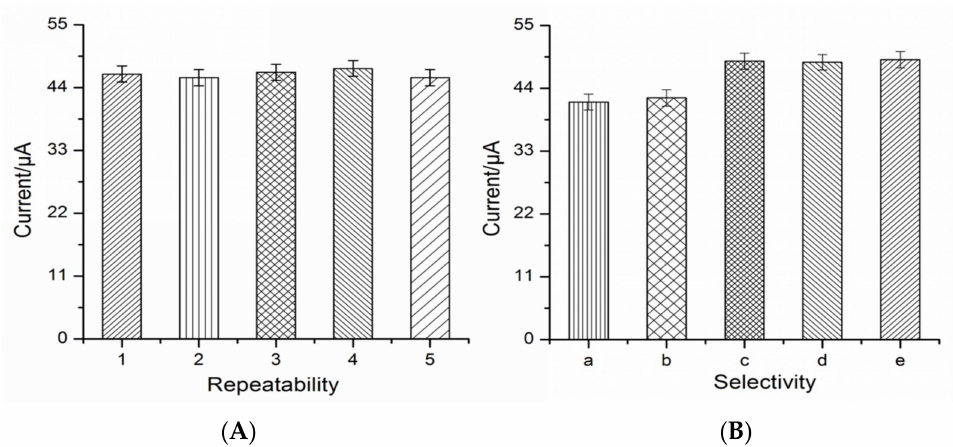
Figure 8. The repeatability of five modified electrodes ( A ) and the selectivity of the immunosensor with norfloxacin ( a ) and some analogues involving enoxacin ( b ), fleroxacin ( c ), mariposide ( d ), and sparfloxacin ( e ) ( B ).